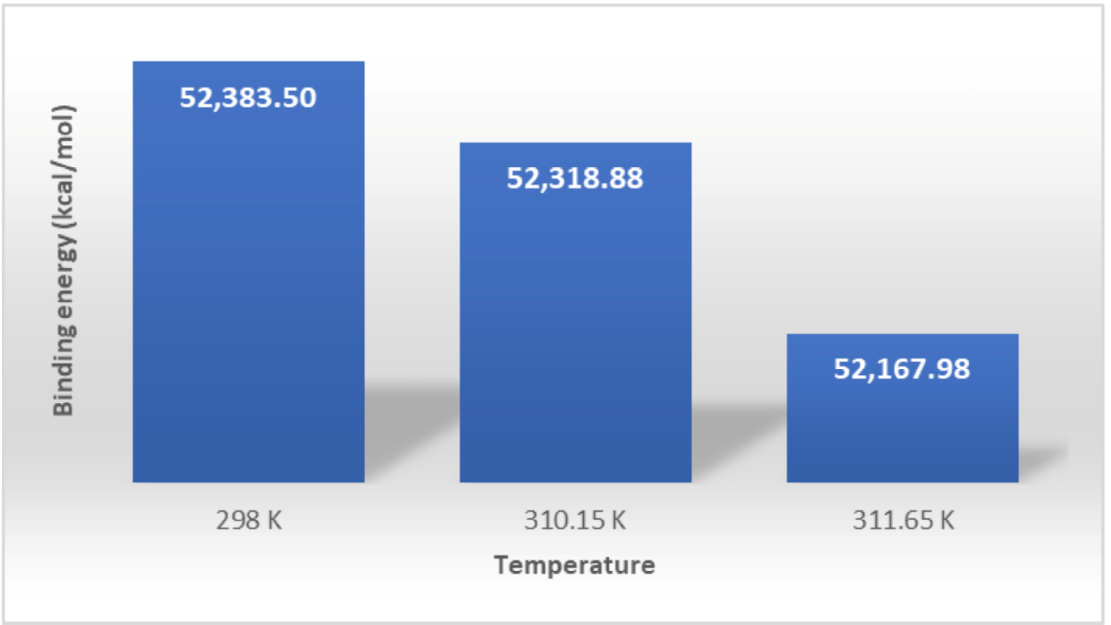
Figure 5. Schematic illustration (left) and MD capture (right) of the fibrinogen and polymeric membrane model ( a ) far from each other and ( b ) interacting with each other.